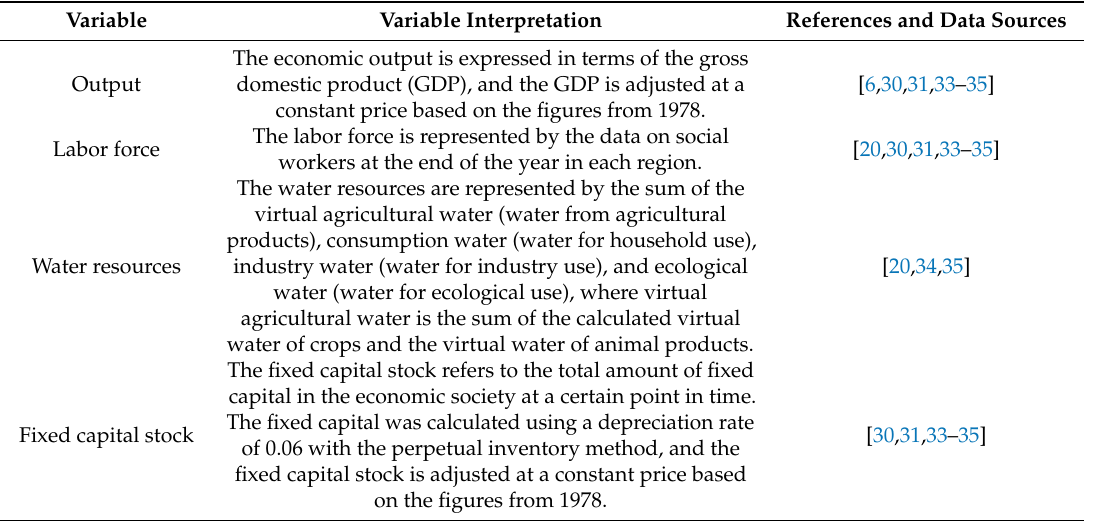
Table 1. Variable